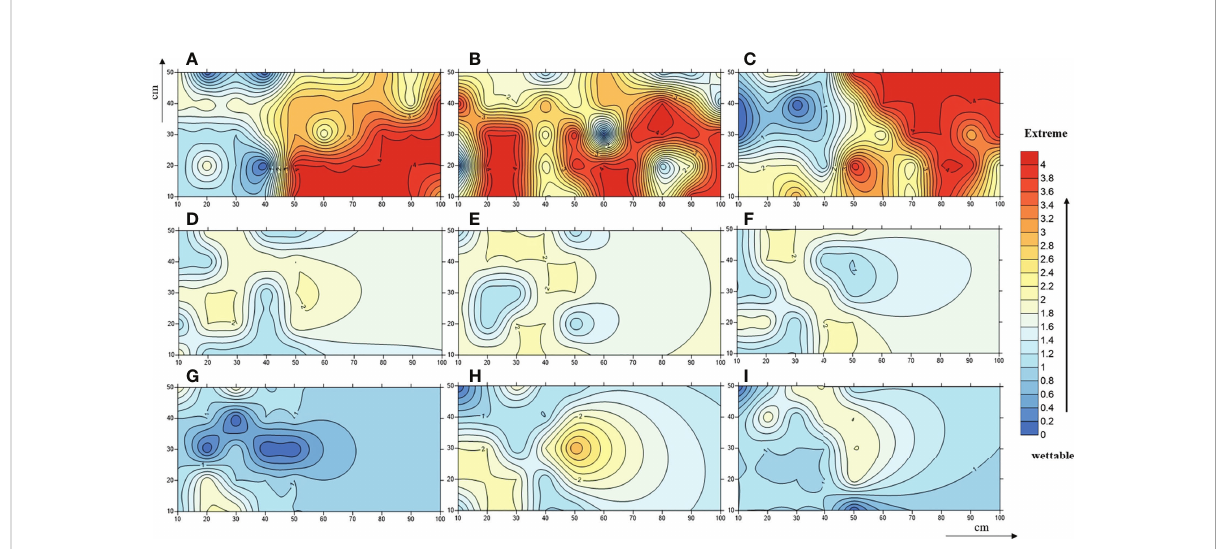
FIGURE 1 A contour map of soil water-repellence classes beneath Pinus (A – C) , Robinia (D – F) , and Hippophae (G – I) . Numbers 0, 1, 2, 3, and 4